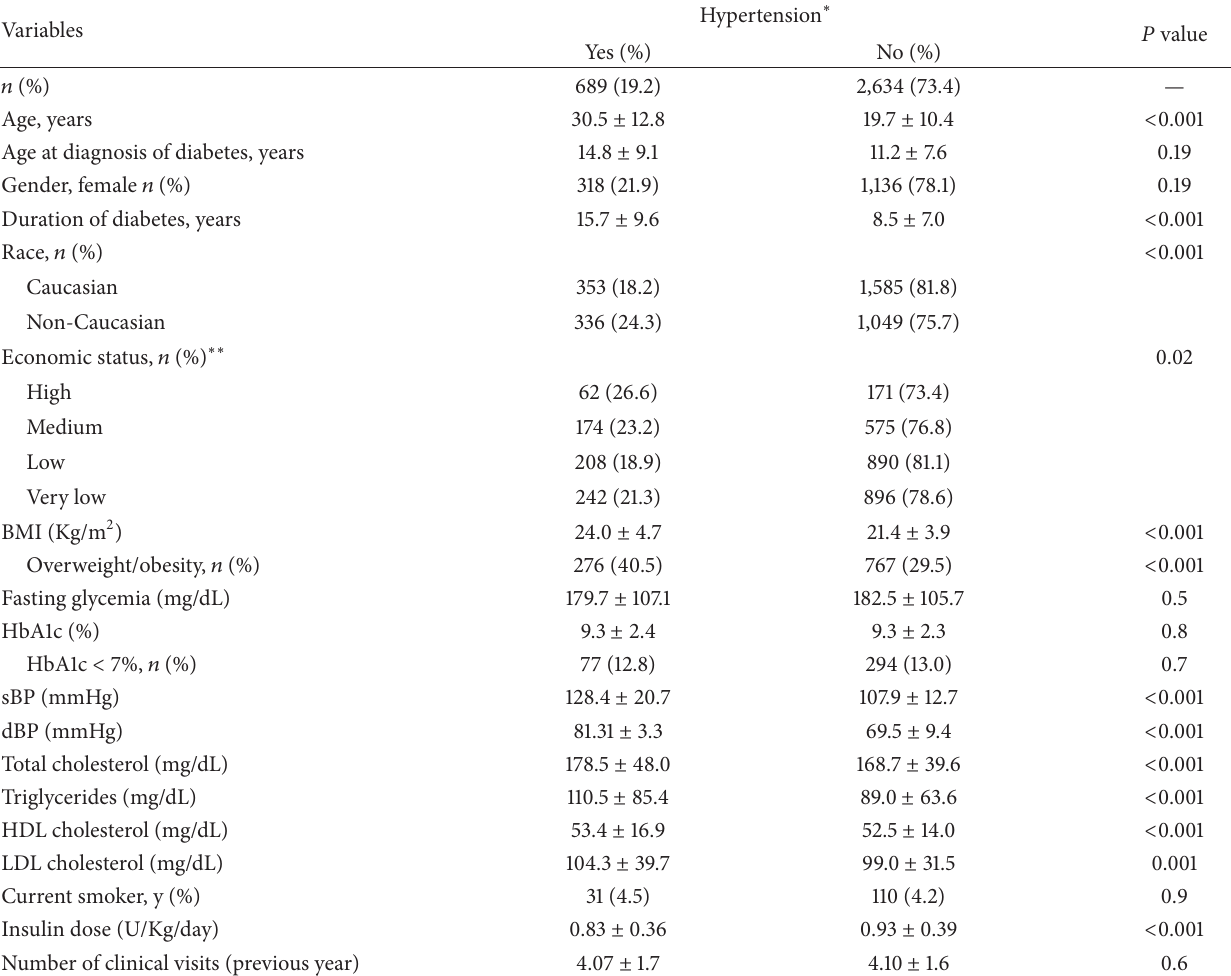
Table 2: Demographic, clinical, and laboratory data for the presence of hypertension in the studied